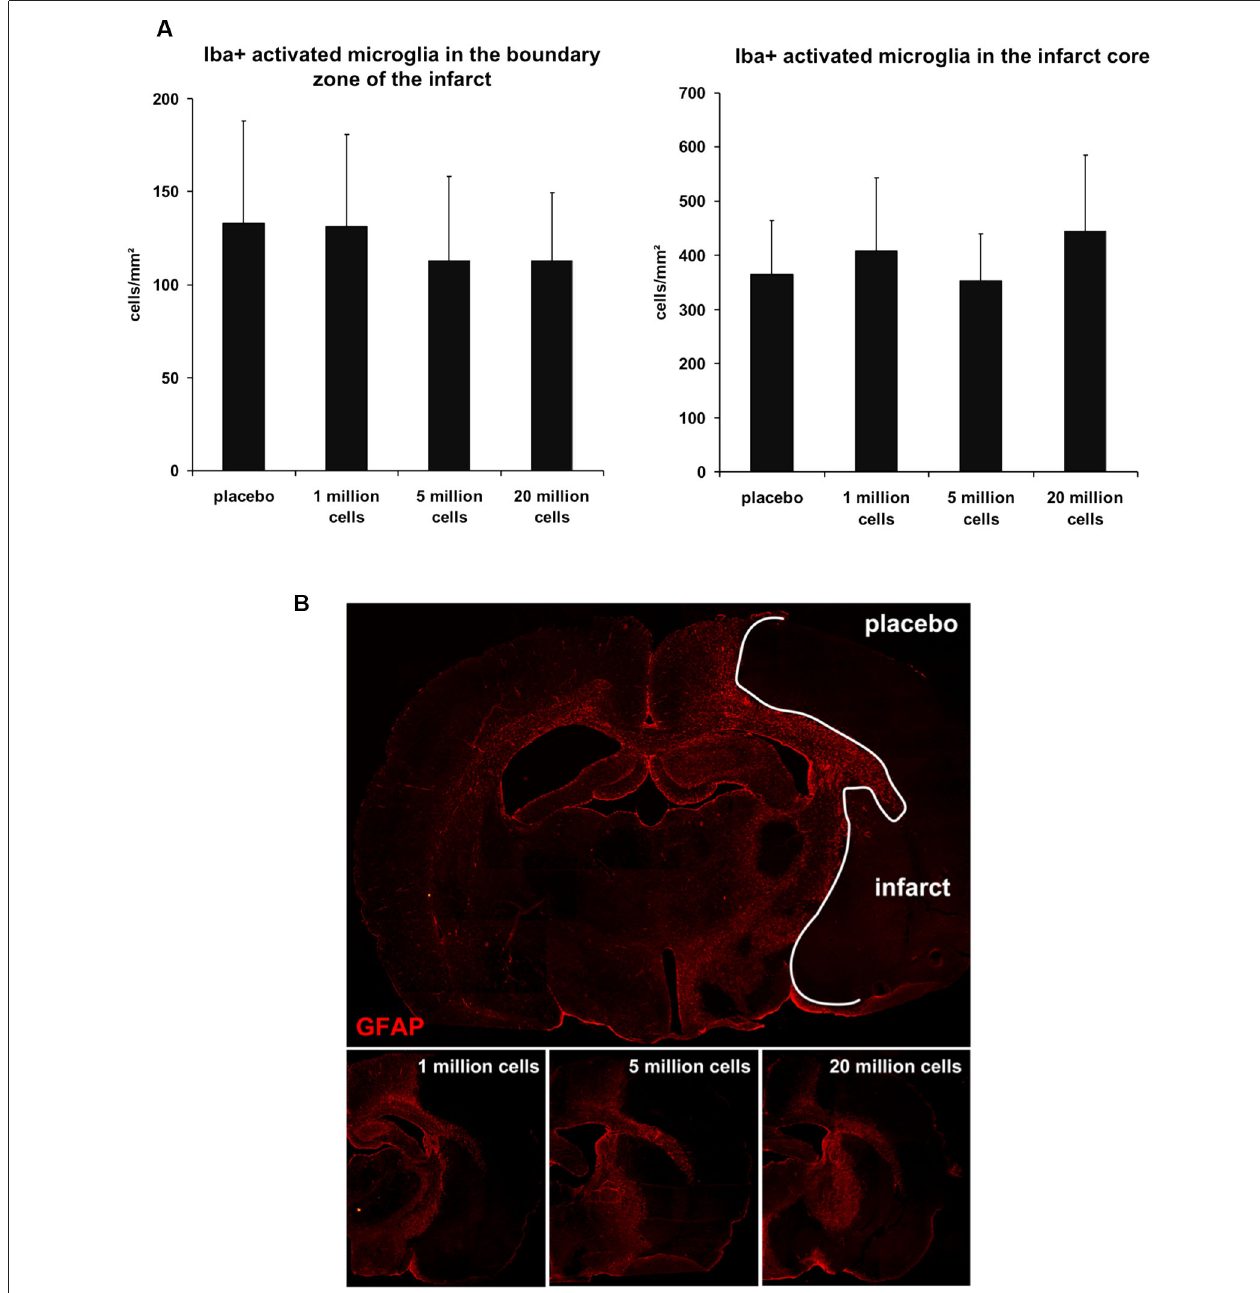
staining visualized the common distribution of astrogliosis surrounding the infarcted tissue. No differences with respect to GFAP-immunoreactivity and morphology between the BM-MNC and the placebo treated groups were observed ( n =